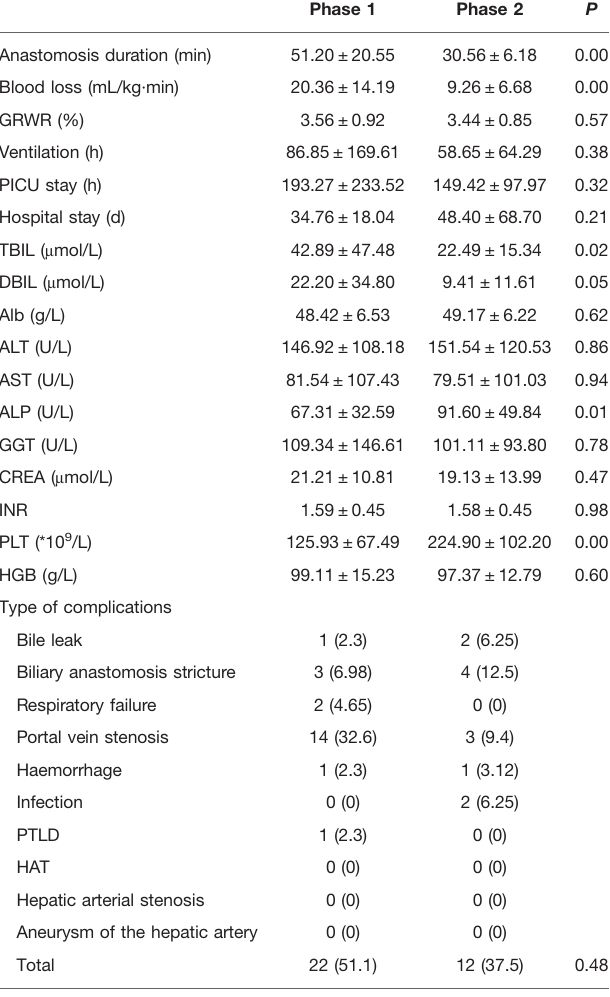
TABLE 4 | Patients ’ operative and postoperative outcome according to phases of the learning curve. Phase 1 Phase